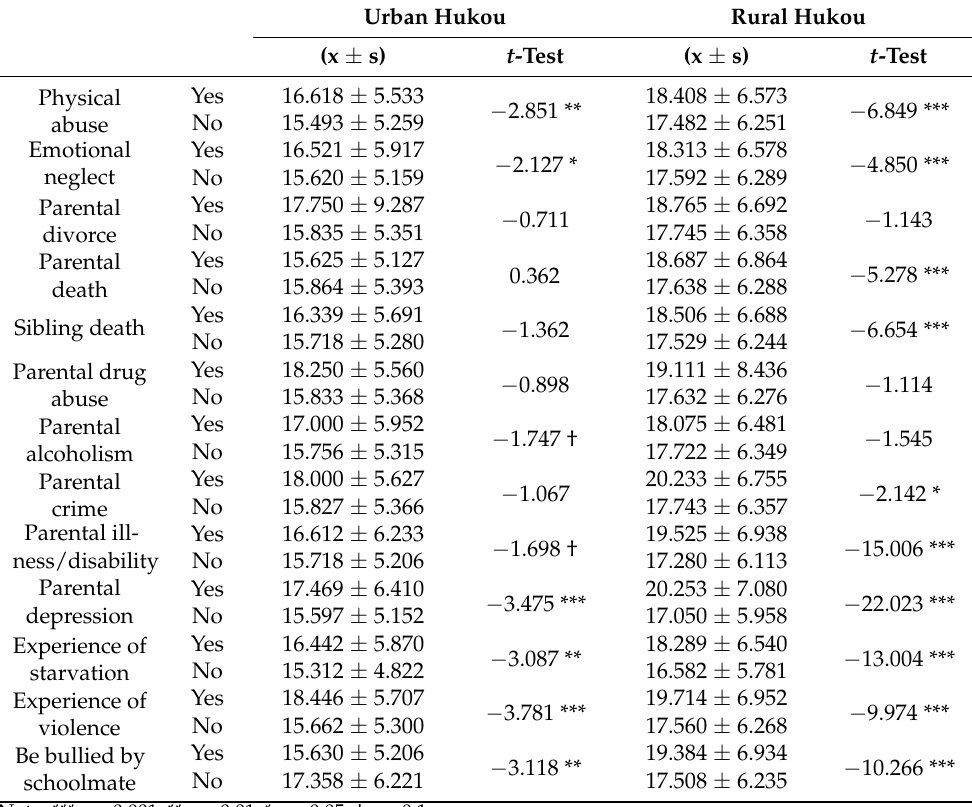
Table 4. The depression scores with different ACEs by Hukou